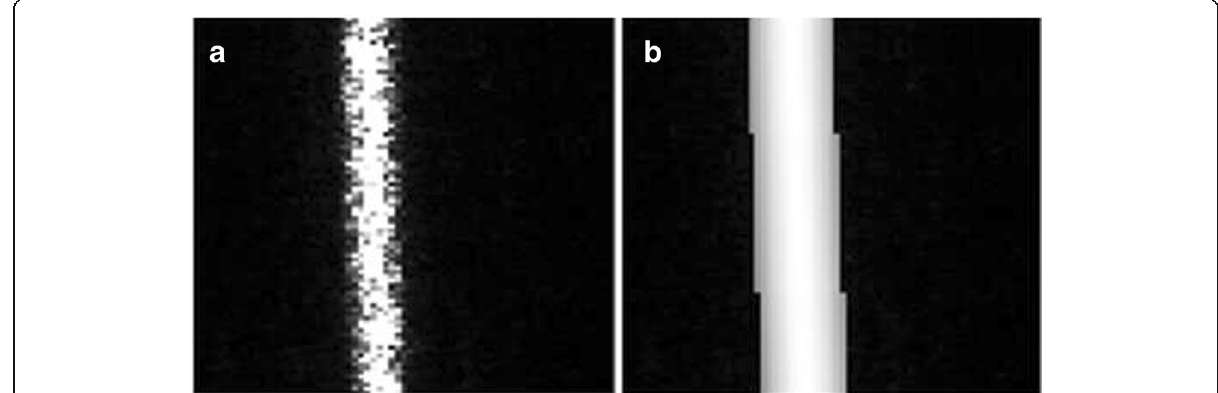
Fig. 5 Comparison of light stripe images before and after optimization. a The light stripe image before enhancement b The light stripe image after enhancement